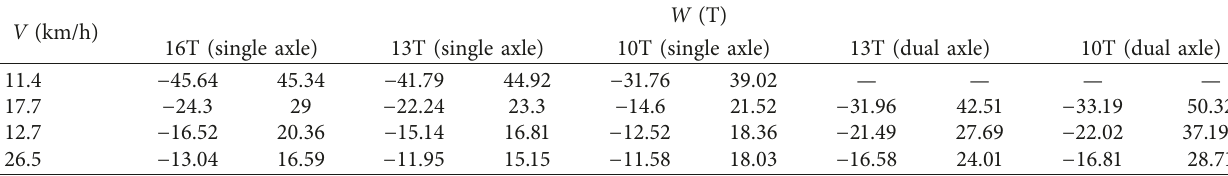
Figure 18: Time accumulation of strain. Table 9: Time accumulation of